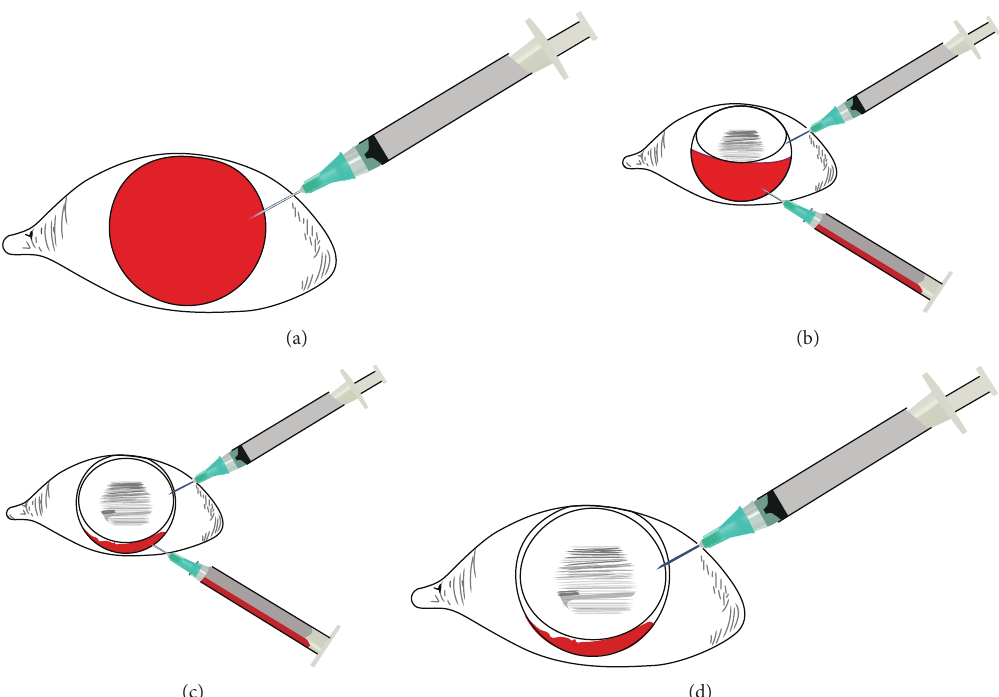
Figure1: (a)Entryintotheanteriorchamber superiorlywith gas-filled syringe. (b)Afterpartial gasinjection, entryintothedeepened anterior chamber inferiorly with evacuation syringe, plunger removed. (c) Evacuation of hyphema with complete or near complete anterior chamber fluid-gas exchange. (d) Inferior needle is removed while superior gas-filled syringe is used to equilibrate intraocular